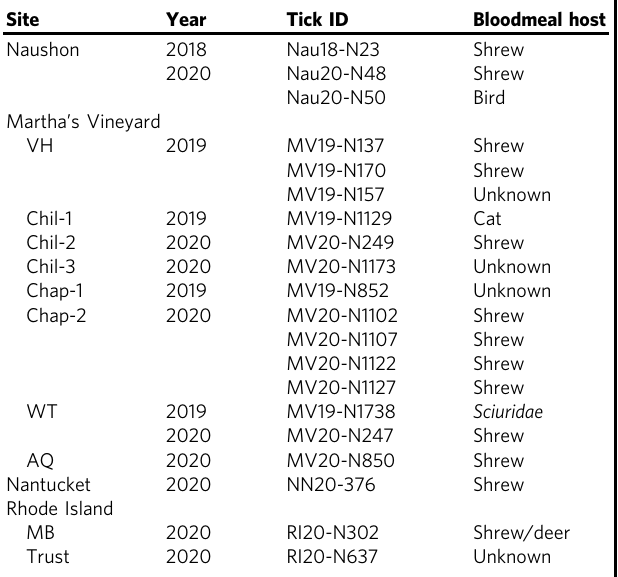
Table 3 Bloodmeal host identi fi ed from deer tick virus- infected ticks from each study